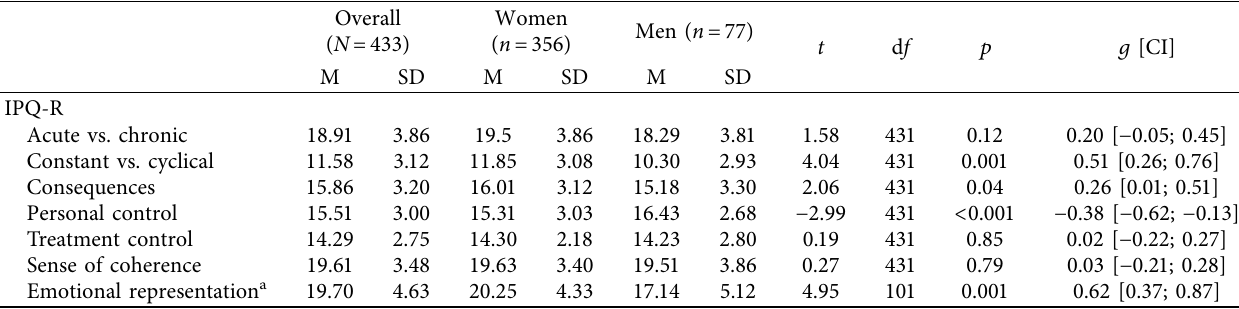
Table 2: Total values of the IPQ-R and gender differences in subjective illness